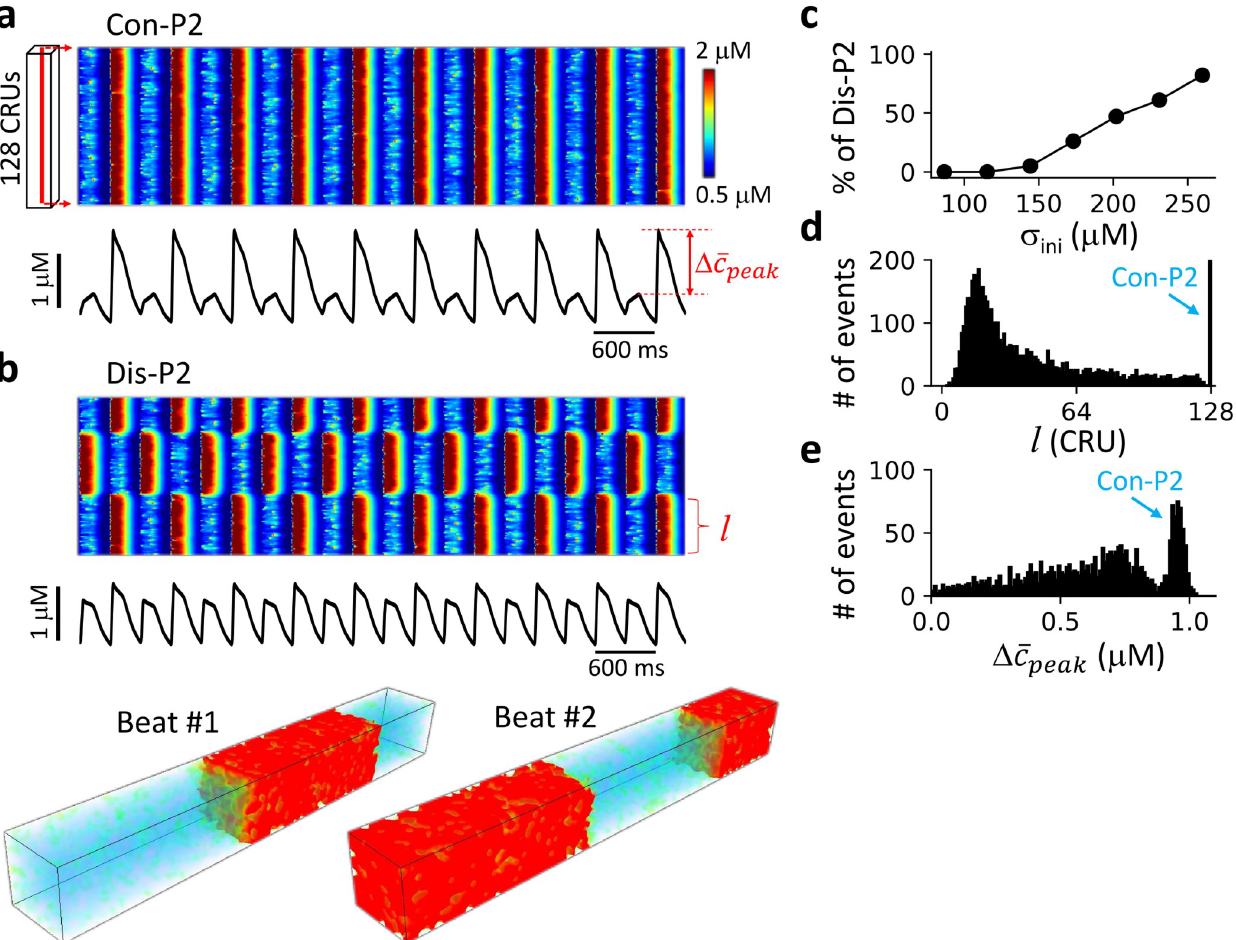
Fig 4. Ca 2+ release patterns and dynamics in the 3D ventricular myocyte model under AP clamp. a . Upper panel shows a linescan (time-space plot) of cytosolic Ca 2+ concentration showing a Con-P2 pattern. Lower panel shows the corresponding whole-cell Ca 2+ transient. The recording line was in the center of the cell as indicated on the left. b . Same as panel a. with a different random initial condition resulting in a Dis-P2 pattern. The middle panel is the corresponding whole-cell Ca 2+ transient. The bottom panels are 3D views of Ca 2+ from two consecutive beats. c . Percentage of Dis-P2 patterns versus the standard deviation ( σ )of initial SR Ca 2+ load. The random spatial distribution of the SR Ca 2 + load was set as Ca ( j ) = Ca 0 + Δ Ca � ξ ( j ) � (j = 1,2, ... ,L) with ξ ini SR SR ffiffiffi p ( j ) being a uniform random number in [–1,1]. s ¼ D Ca = 3 . We set Ca 0 = 500 μ M. We performed 100 trials for each σ ini value in the plot. d . Histogram ini SR of domain size l (as marked in panel b) with Δ Ca SR = 450 μ M. e . Histogram of global P2 amplitude D � c (as marked in panel a) from the same simulations peak in panel d. For panel d and e, 2000 trials were performed. For each trial, the cell was paced 2000 beats to reach a steady state. The domain size was computed was measured using the last 50 beats to account for beat-to-beat variation (see SI for details) due to the intrinsic noise of ion channel stochasticity. D � c peak using the last two beats. The pacing period T = 300